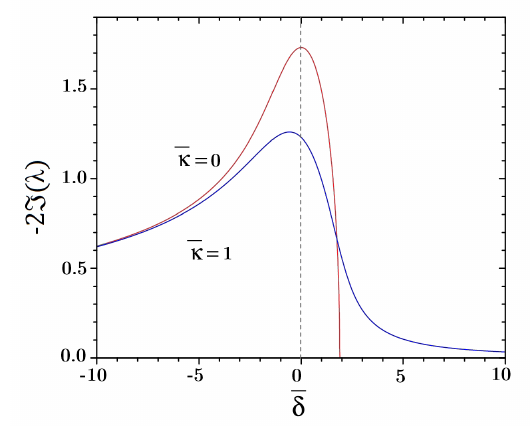
Figure 3. − 2 (cid:61) ( λ ) vs. ¯ δ for ¯ κ = 0 and ¯ κ = 1. In the ‘good-cavity’ limit, ¯ κ → 0, the cubic equation has three real roots for ¯ δ > δ T = ( 27/4 ) 1/3 ∼ 1.89, and one real and two complex conjugate roots for ¯ δ < δ √ T . The maximum growth (i.e., the maximum of (cid:61) ( λ ) ) occurs on resonance, δ = 0, with λ = ( 1 − i 3 ) /2. √ √ The intensity | A | 2 grows as exp ( 3 ¯ t ) = exp ( Gt ) , where G = 3 ( 8 ω r ρ ) is the